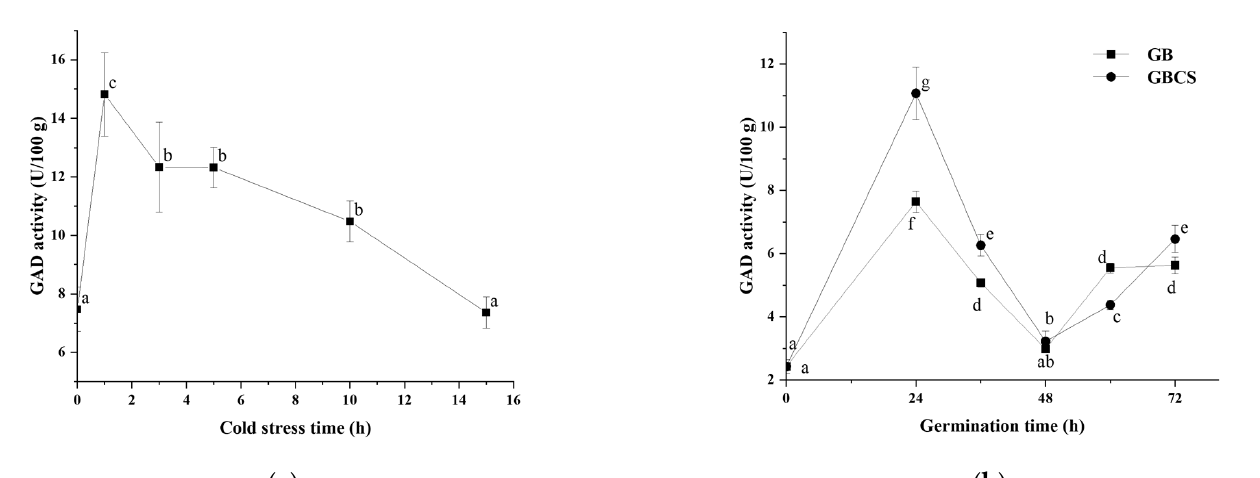
Figure 3. Change in GAD activity in fl uenced by cold stress and germination. GB, germinated black rice grain without cold stress; GBCS, germinated black rice grain under cold stress at 0 °C for 1 h; ( a ) represents the change in GAD activity in fl uenced by cold stress time; ( b ) represents the change in GAD activity in fl uenced by germination time with or without cold stress. Means with di ff erent small le tt er superscripts are signi fi cantly di ff erent at p < 0.05.